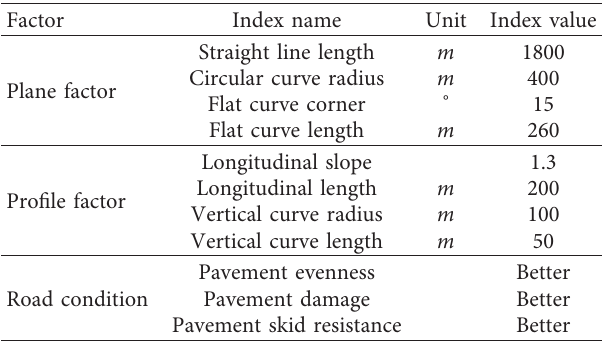
Figure 7: Distribution center and distribution station topology map. Table 3: Evaluation index